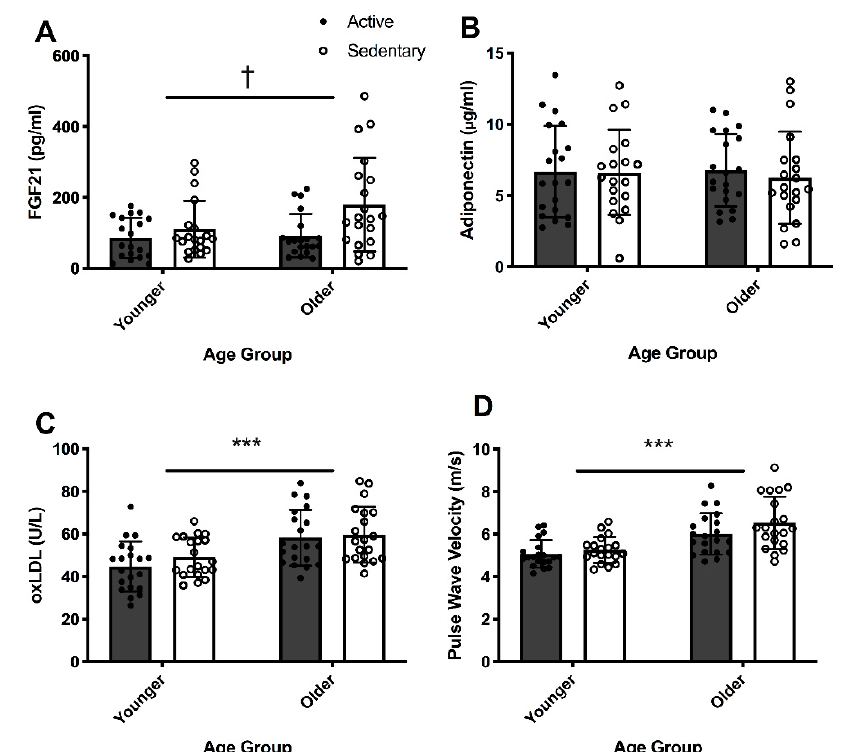
Figure 2. Two-way analysis of variance (age × exercise) of fibroblast growth factor 21 (FGF21) ( A ), adiponectin ( B ), oxidized low-density lipoprotein (oxLDL) ( C ) concentrations and pulse wave velocity (PWV) ( D ) in younger active (YA) ( n = 20, M / F = 10 / 10) and sedentary (YS) ( n = 20, M / F = 10 / 10), and in older active (OA) ( n = 20, M / F = 11 / 9) and sedentary (OS) ( n = 20, M / F = 12 / 8) individuals. Two-way ANOVA for FGF21 concentration was conducted only for YA ( n = 19, M / F = 10 / 9), YS ( n = 19, M / F = 9 / 10), OA ( n = 20, M / F = 11 / 9) and OS ( n = 20, M / F = 12 / 8) groups *** = p < 0.001 for age. † = p < 0.05 for exercise status. Black circles represent active individuals and white circles represent sedentary individuals within younger and older groups.